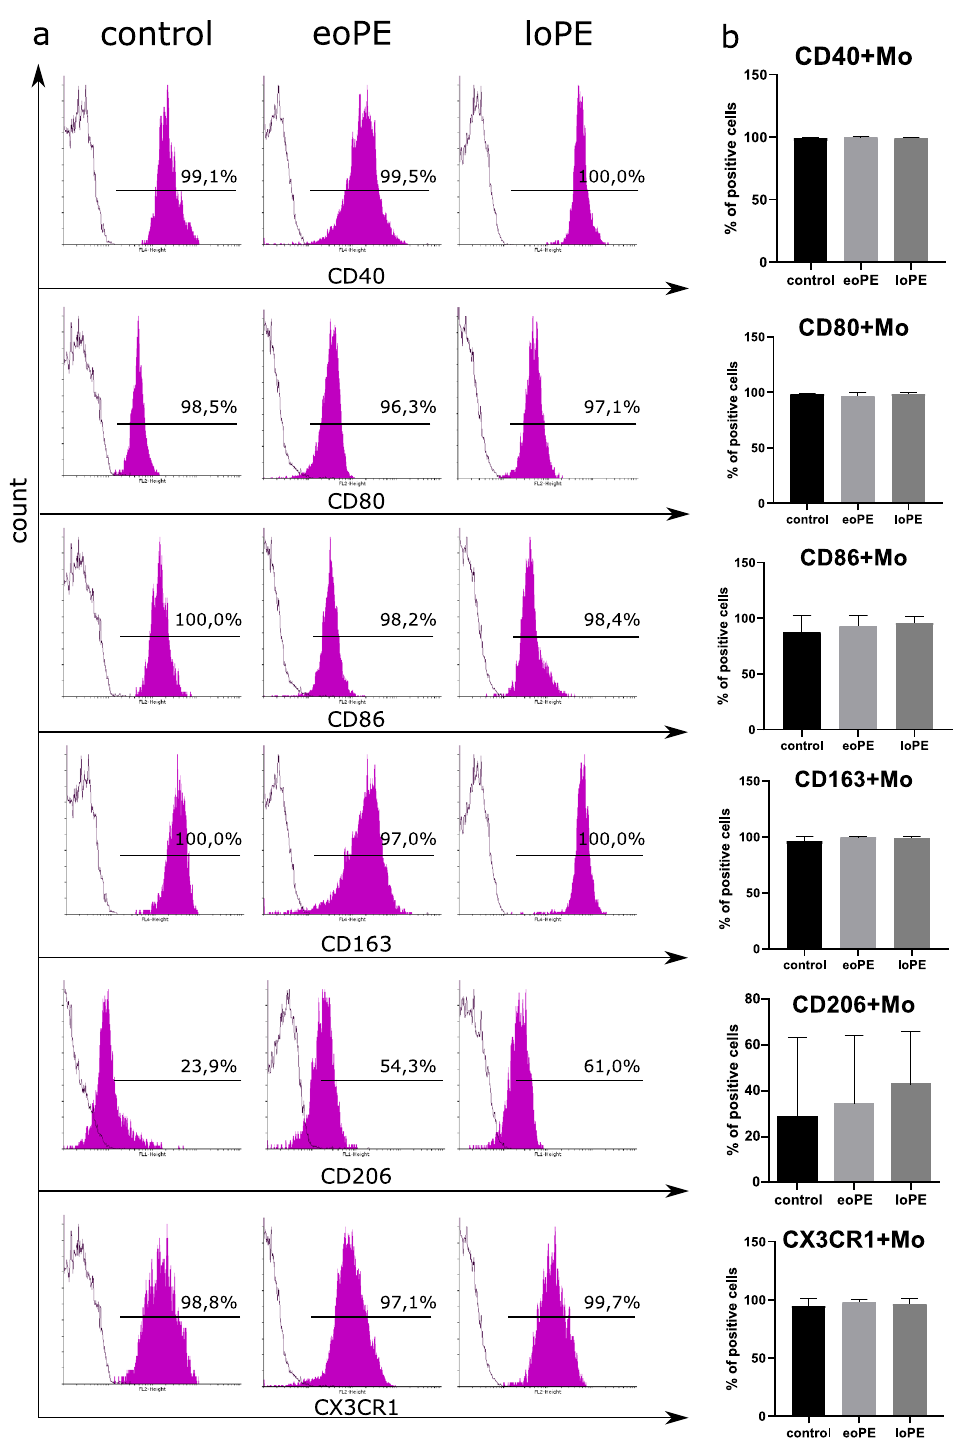
Figure 2. Immunophenotyping of the patient’s monocytes. Representative histograms of gated monocytes stained with antibodies to CD40, CD80, CD86, CD163, CD206 or CX3CR1 (magenta-filled histogram) and control samples (empty contour) for three groups of patients ( a ). Percents of positively stained cells are indicated above the gate bars. Levels of CD40+, CD80+, CD86+, CD163+, CD206+ and CX3CR1+ monocytes in three groups: the data are listed as mean ± SD ( b ): eoPE early-onset PE (n = 12), loPE late-onset PE (n = 10), control (n =